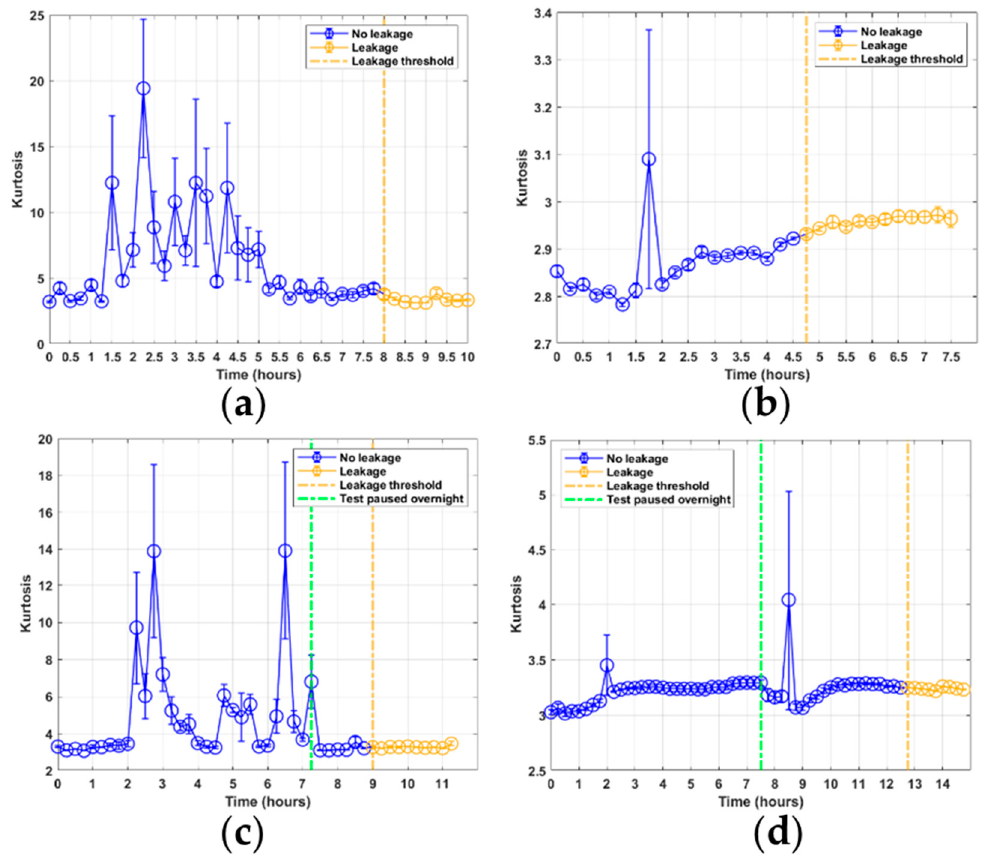
Figure 8. Kurtosis feature results from RTF tests 1–4: ( a ) test 1; ( b ) test 2; ( c ) test 3; ( d ) test 4.